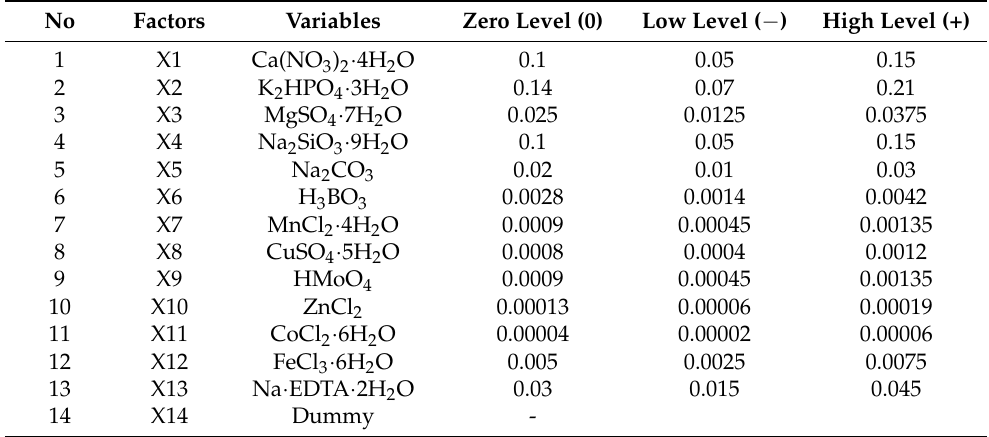
Table 1. Variables investigated of the modified Navicula medium via Plackett–Burman design for Anabaena variabilis